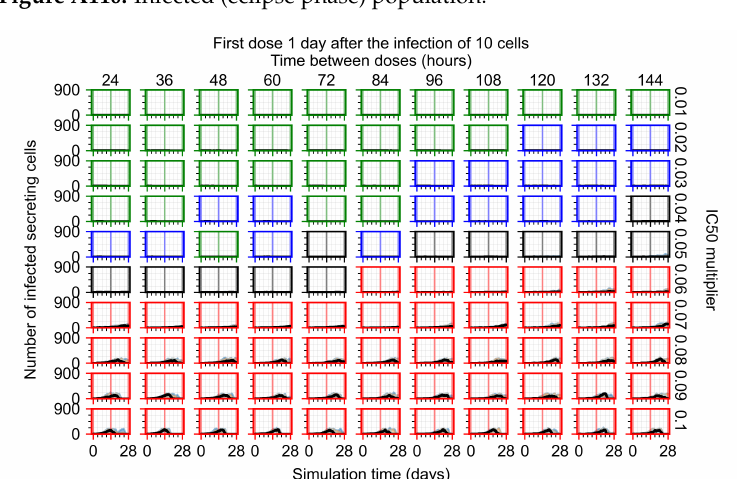
Figure A111. Infected (secreting extracellular virus) population.